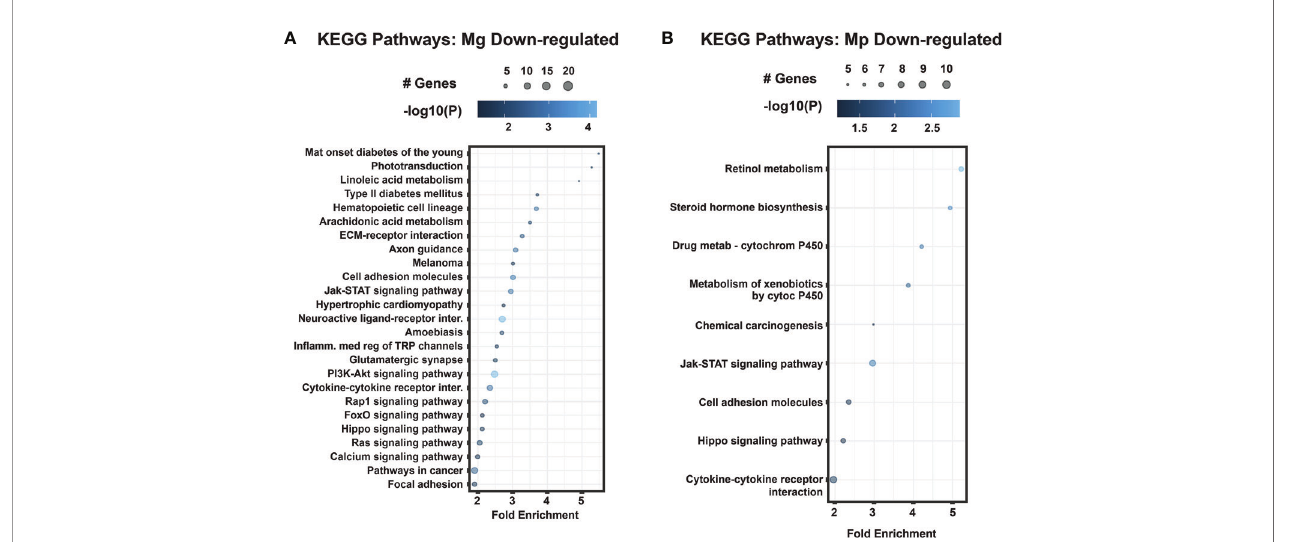
FIGURE 3 | KEGG pathways for differentially expressed down-regulated genes M. genitalium (Mg) and M. pneumoniae (Mp). (A) Dot blot for Mg down-regulated genes, (B) Dot blot for Mp down-regulated genes. Dot blots measure fold enrichment of the pathways, dot size represents total number of genes included in each category, and gradient color shows statistical signi fi cance [-log 10 ( P